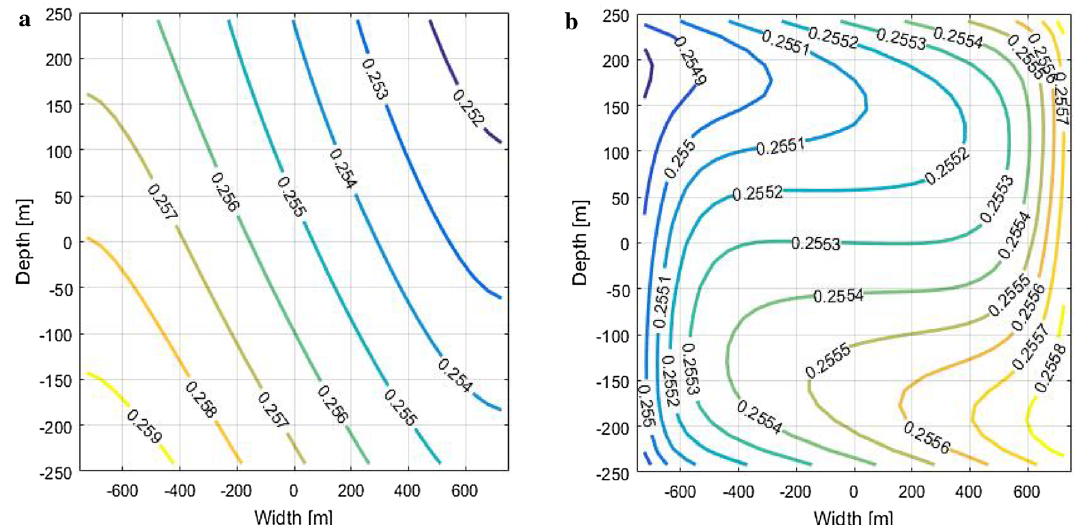
Fig. 10 a Contour plot of C 7+ composition, convection-free, volatile oil. b Contour plot of C 7+ composition, with natural convection, k = 1 md, volatile oil